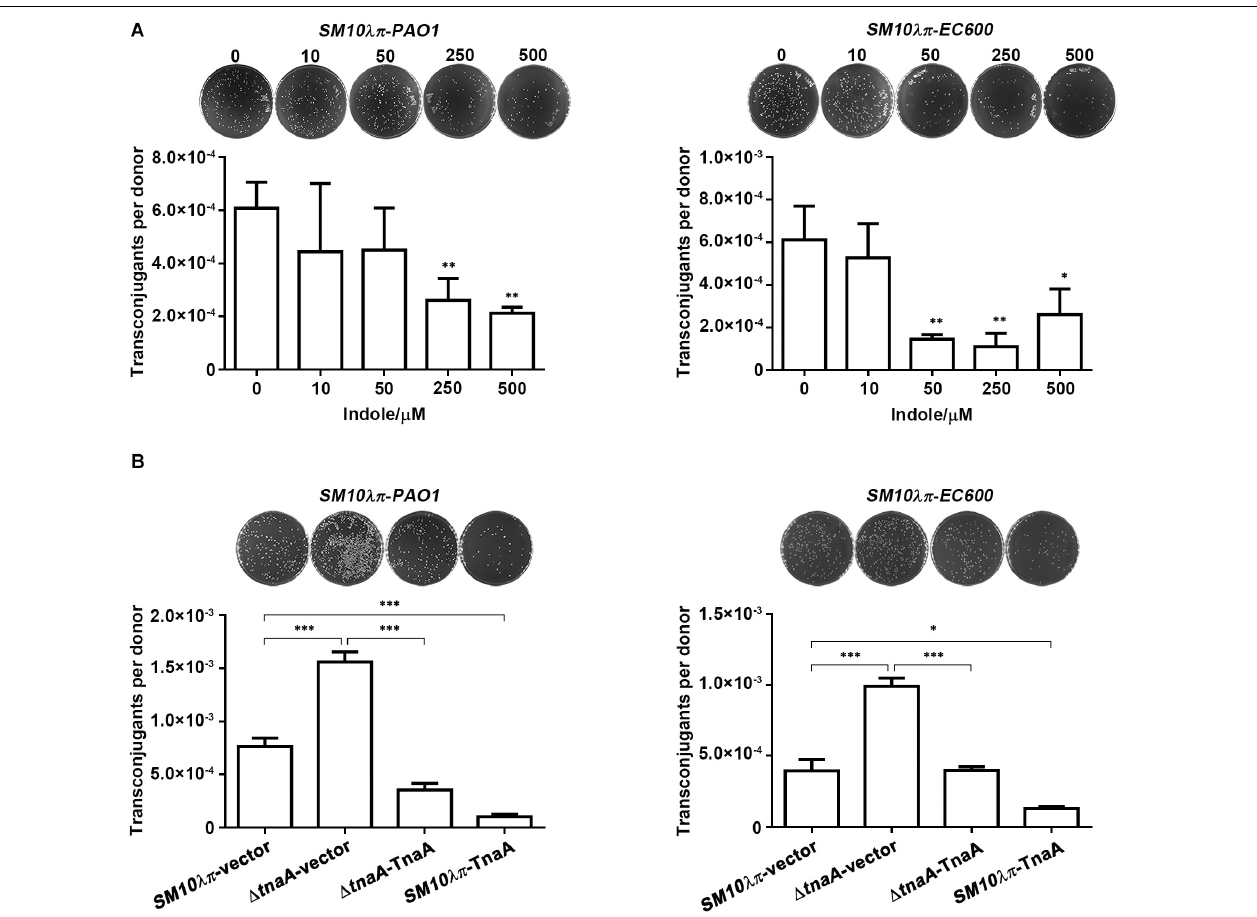
FIGURE 1 | Indole inhibited SM10 λπ - PAO1 and SM10 λπ - EC600 conjugation. (A) Effect of exogenous indole on SM10 λπ - PAO1 and SM10 λπ - EC600 conjugation. Donor SM10 λπ and recipient PAO1 or EC600 cells (1 × 10 7 CFU/ml each) were mated in the presence of indicated concentrations of indole at 37 ◦ C for 6 h. (B) Effect of endogenous indole on SM10 λπ - PAO1 and SM10 λπ - EC600 conjugation. SM10 λπ wild-type strain ( SM10 λπ -vector), tnaA -deficient strain ( (cid:49) tnaA -vector), TnaA overexpression strain in wild-type ( SM10 λπ -TnaA), and tnaA mutation ( (cid:49) tnaA -TnaA) were mated with PAO1 or EC600 cells (1 × 10 7 CFU/ml each), respectively, at 37 ◦ C for 6 h. Values are means ± SEMs from at least three independent experiments; ∗ P < 0.05; ∗∗ P < 0.01; ∗∗∗ P < 0.001.